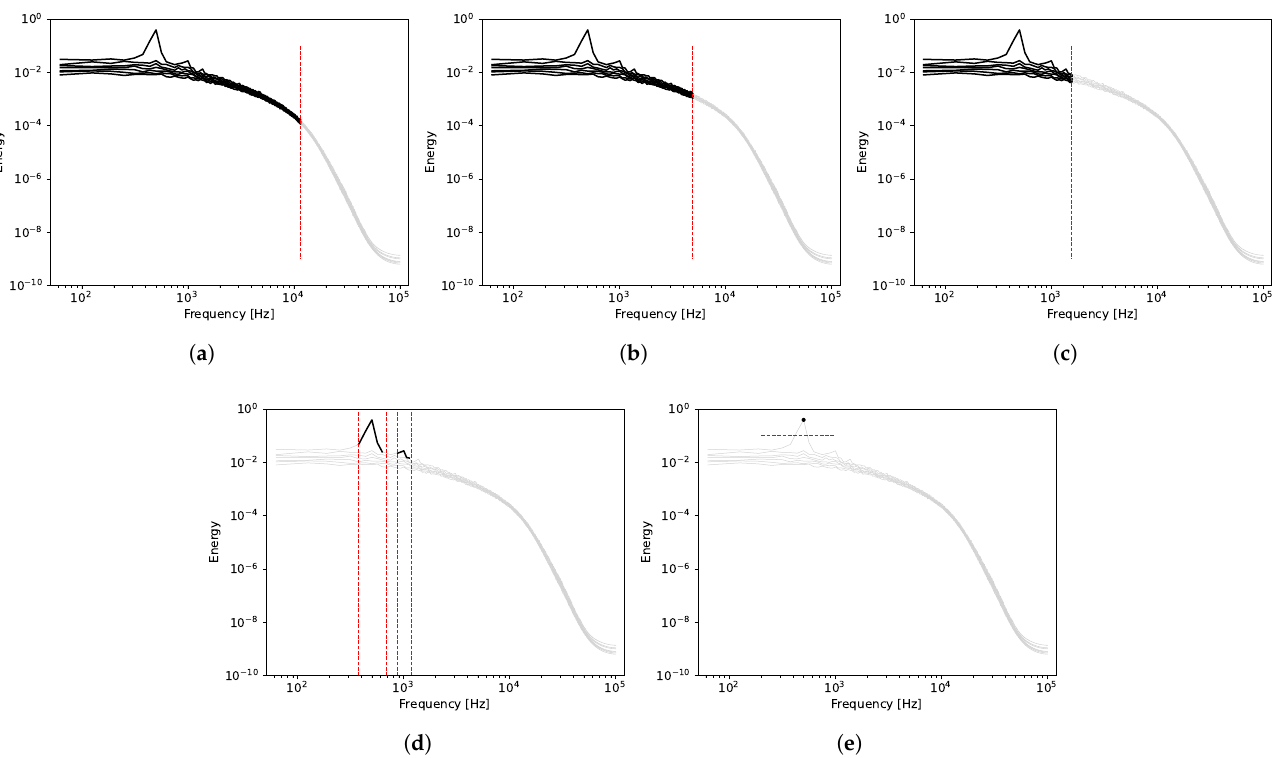
Figure 12. SPOD spectra of the partial reconstructions. ( a ) F99. ( b ) F90. ( c ) F65. ( d ) F20. ( e ) F10. The exact characteristics of the different SPOD reconstructions are presented in Table 2. The last column of the table contains additional information: the cost of storing the cor- responding information. The main idea of the partial reconstruction of the database is to provide a boundary condition signal which best replicates the coupling between the cham- ber and the turbine while using a smaller database than the set of initial snapshots. This storage cost is expressed relative to the size of the initial